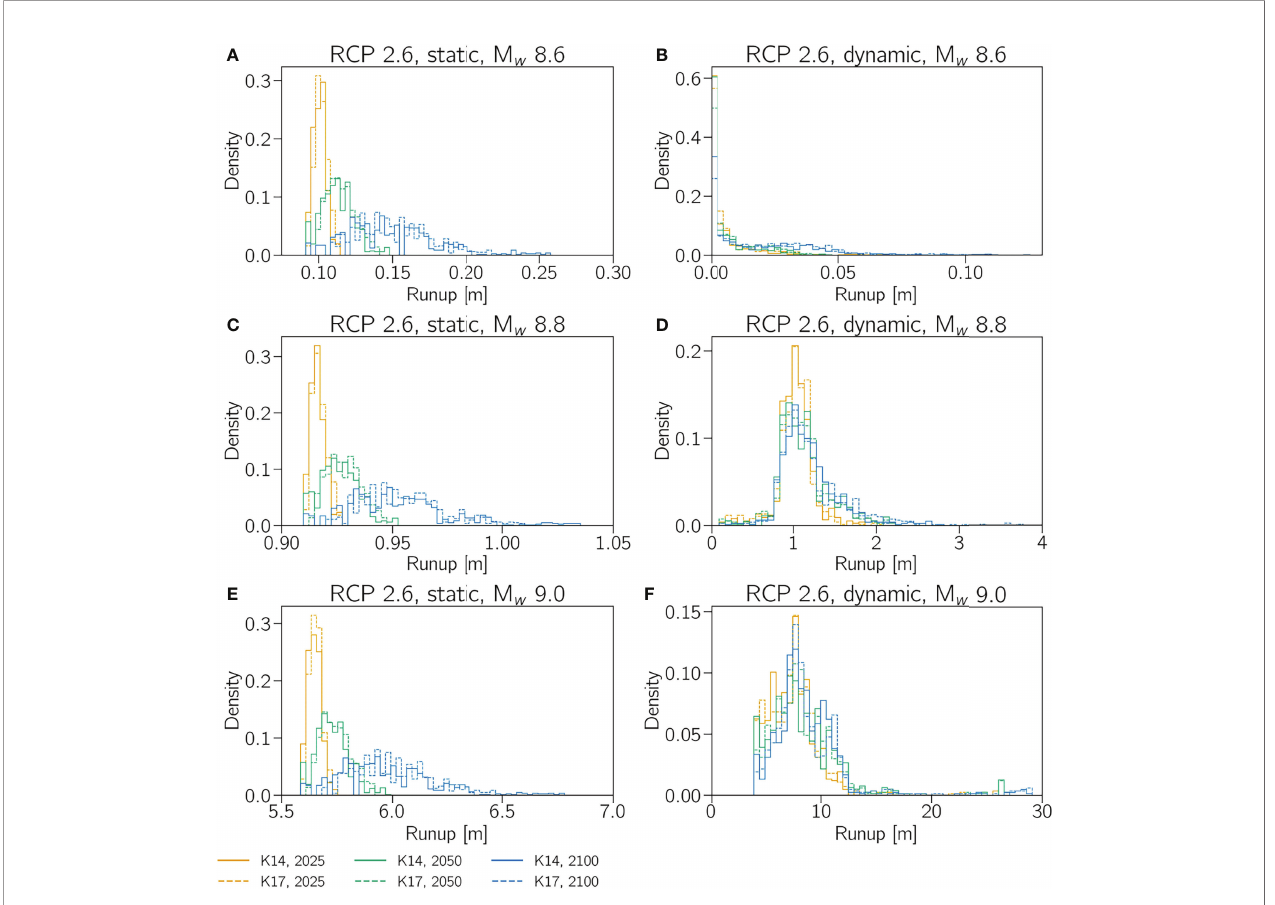
FIGURE 4 | Probability densities of run-up for M w 8.6, 8.8, and 9.0 for RCP 2.6 for the static bathymetry (A, C, E) and dynamic bathymetry (B, D, F) for K14 and K17 for the years 2025, 2050, and 2100. Note that the ranges of the x-axes were chose to highlight the nearly order of magnitude differences between (A, C, E) , and (B, D, F)